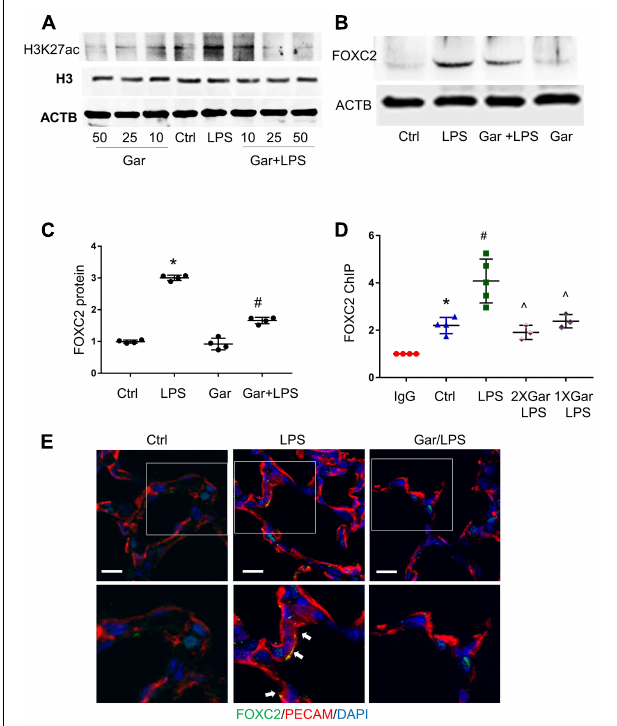
FIGURE 4 | CRISPR/dCas9/FBE gRNA blocks LPS-stimulated FOXC2 binding, represses autoregulation in HPMEC-Im, and alters EC character. (A) dCas9 protein expression in stable cell line of HPMEC-Im/dCas9 was shown by immunoblotting, but no expression in control HPMEC-Im. (B) FOXC2 RNA expression was quantified by qTR-PCR 2 days after gRNA mix were transfected into HPMEC-Im/dCas9, with or without 4-h LPS treatment. n = 5 per group, * p < 0.05, LPS vs. Ctrl; # p < 0.05, gRNAs + LPS vs. LPS. (C) FOXC2 protein was quantified by immunoblotting from cell lysate 6 h after LPS treatment with or without gRNAs transfection, with densitometry shown graphically (D) . n = 6, * p < 0.01, LPS vs. ctrl; # P < 0.001, gRNAs + LPS vs. LPS. (E) ChIP with anti-FOXC2 antibody was performed 30 min after LPS treatment of gRNAs transfected HPMEC-Im/dCas9. n = 5 per group, * p < 0.05, LPS vs. ctrl; # p < 0.05 gRNAs + LPS vs. LPS. (F) FOXC2, LYVE-1, PROX-1 and Thy1 RNA expression was quantified 2 days after gRNAs were transfected into HPMEC-Im/dCas9. n = 7 per group, * p < 0.05.